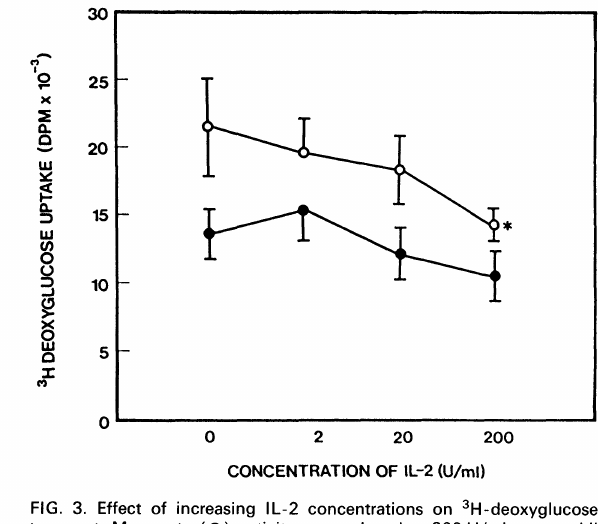
FIG. 3. Effect of increasing IL-2 concentrations on 3H-deoxyglucose transport. Monocyte ((C)) activity was reduced at 200 U/ml, neutrophil (0) activity was unaffected. Final cell concentrations were 2 x 106 neutrophil/ml and x 106monocyte/ml; 3H-DOG concentration was 0.78/Ci/ml. p <